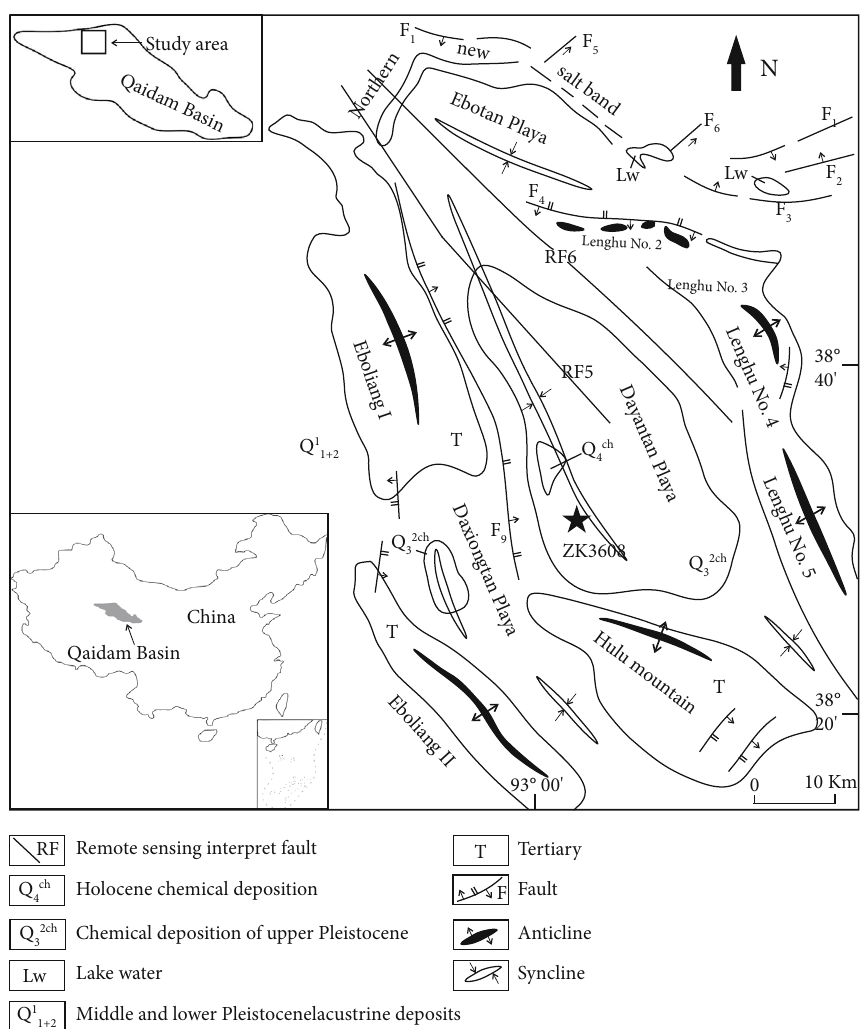
Figure 1: Schematic geological map of Kunteyi Playa in QB, China, and the location of core ZK3608 (modi fi ed after